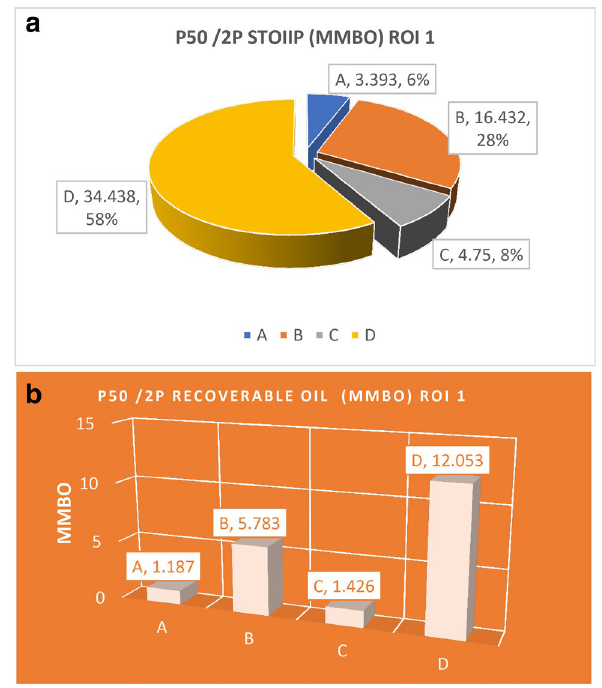
Fig. 9 a P90/1P STOIIP pie chart of reservoirs A–D at ROI 1. b P90/1P recoverable oil chart of reservoirs A–D at ROI 1 Fig. 10 a P50/2P STOIIP pie chart of reservoirs A–D at ROI 1. b P50/2P recoverable oil chart of reservoirs A–D at ROI 1